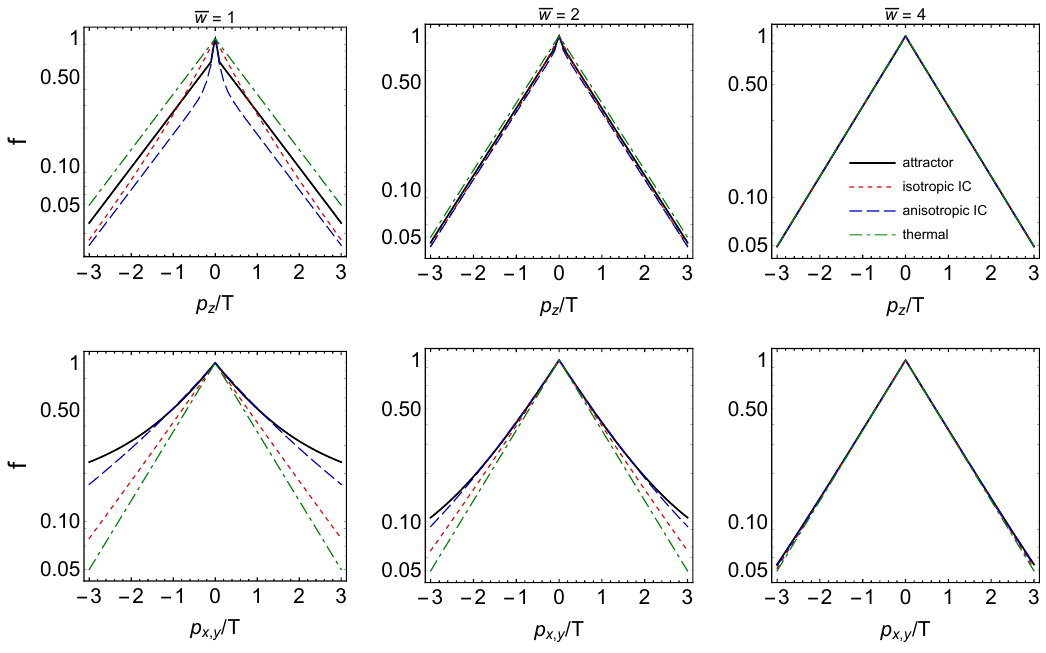
Figure 9 . Attractor for the full distribution function. The solid black line is the attractor result, the red short-dashed line is a typical exact solution with isotropic initial conditions, the blue long- dashed line is a typical exact solution with anisotropic initial conditions, and the green dot-dashed is a thermal distribution using the e(cid:11)ective temperature obtained from the exact attractor solution. The top row shows f ( p T ; p z = 0) and the bottom row shows f ( p T = 0 ; p z ). The columns correspond to di(cid:11)erent scaled times w